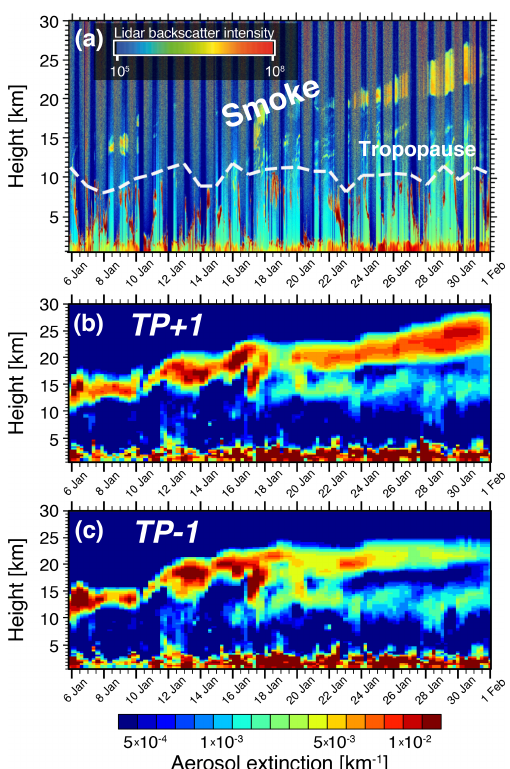
Figure 5. Comparison of the pattern of the temporal evolution of stratospheric smoke observed by lidar measurements and model re- sults at Punta Arenas, Chile for January 2020. (a) Time-height cur- tain plot of aerosol attenuated backscatter coefficient from the Pol- lyXT lidar at Punta Arenas in southern Chile (53.14 ◦ S, 70.89 ◦ W). (b) and (c) Simulated aerosol extinction for the model results the cases TP + 1 and TP − 1 , respectively.